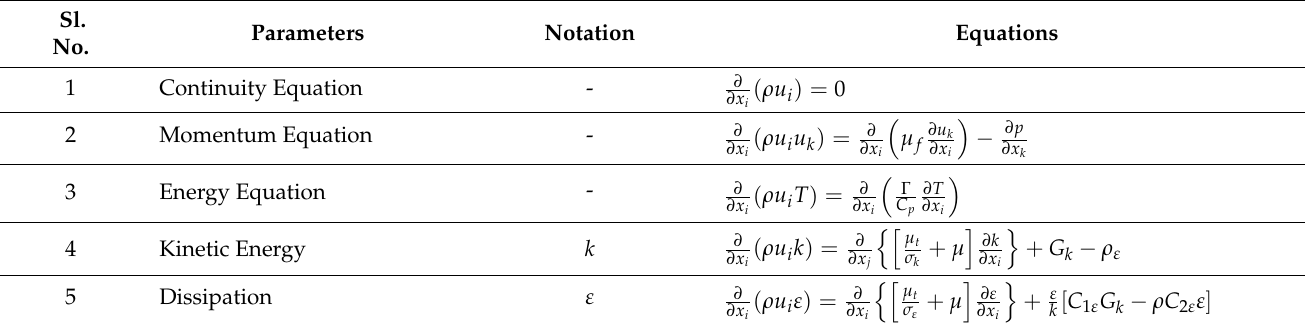
Table 4. Governing CFD